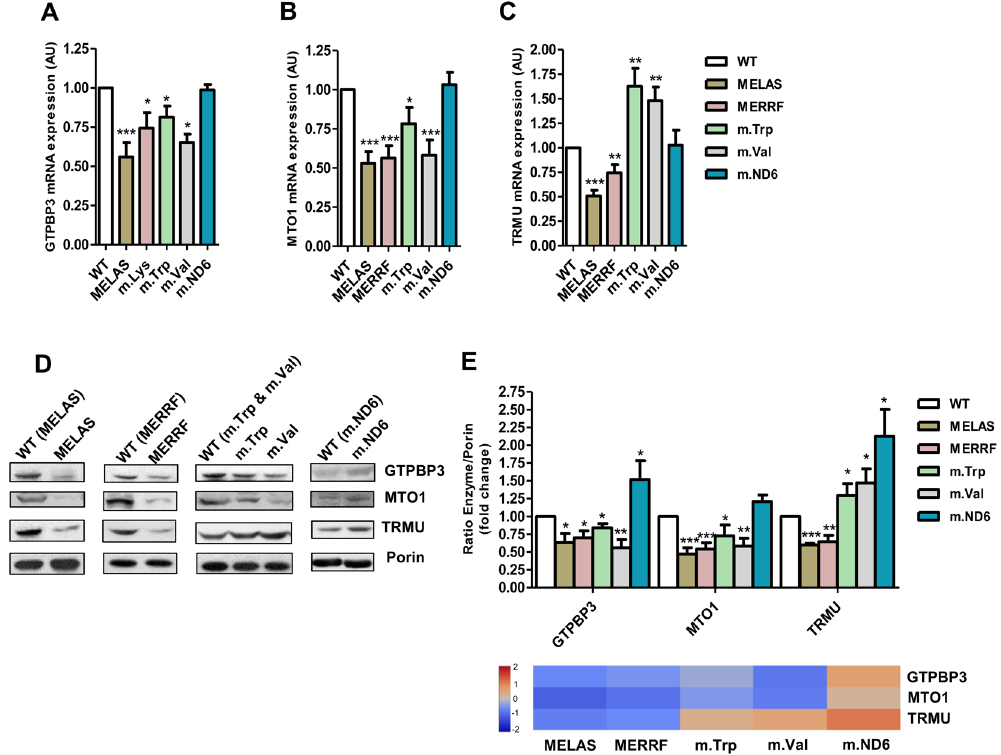
Figure 2. Specific expression pattern of U34 modifying enzymes in the different cybrid cells. ( A–C ) qRT-PCR analysis of GTPBP3 ( A ), MTO1 ( B ) and TRMU ( C ) mRNA expression in mutant and WT cybrid cells. ( D ) Western blot analysis of GTPBP3, MTO1 and TRMU in mutant and WT cybrid cells. The membrane was also probed with porin as a loading control. Full-length western blots are included in supplementary information. ( E ) Densitometric analysis of GTPBP3, MTO1 and TRMU normalized to porin and represented as fold change relative to WT (top). Results from this analysis are also shown as a heatmap (bottom). The color and the corresponding value in log 2 scale are depicted on the left. All data are the mean ± SEM of at least three different experiments. Differences from WT values were found to be statistically significant at * p < 0.05, ** p < 0.01 and *** p < 0.001. AU: arbitrary